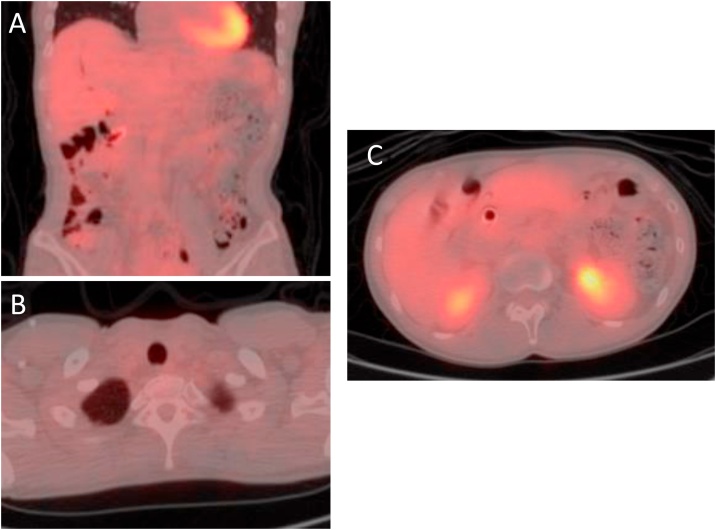
Positron emission tomography (PET)-CT scan just before conversion surgery showing no distant metastases. A: para-aortic lymph nodes; B: left supraclavicular lymph node; C: primary lesion.